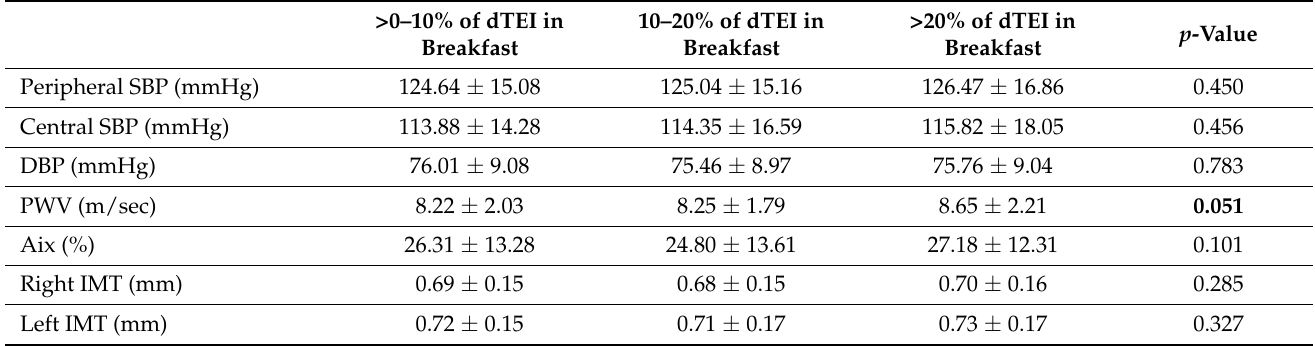
Table 2. Subclinical vascular biomarkers according to % dTEI consumed at breakfast among system- atic breakfast